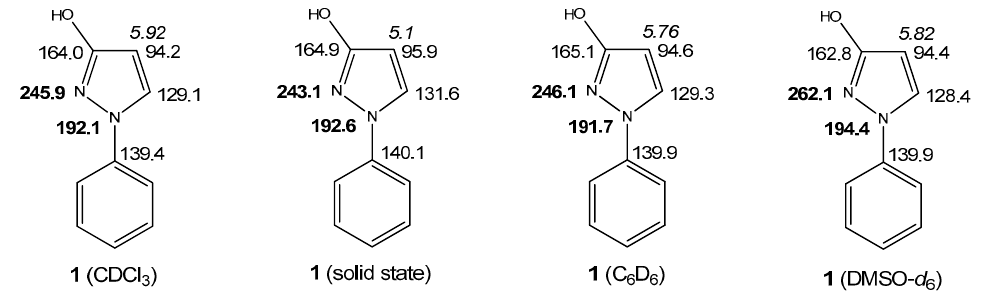
Figure 4. Crucial chemical shifts of 1 in solid state and in different solvents. 1 H-NMR chemical shifts are represented in italics, 13 C-NMR chemical shifts in plain text, 15 N-NMR chemical shifts in bold.